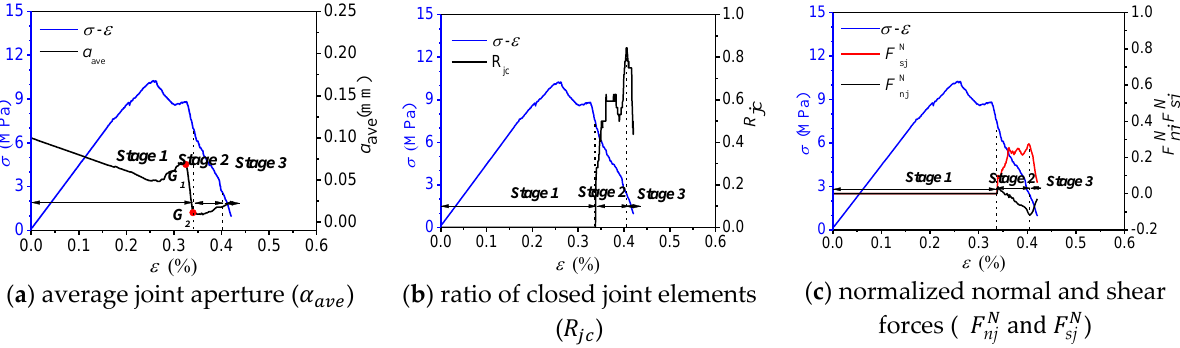
Energies 2021 , 14 , x FOR PEER REVIEW Figure 13. Evolution of the parameters of the joint system with increasing axial strain ( β = 45 ◦ ) Figure 13. Evolution of the parameters of the joint system with increasing axial strain ( 𝛽 =45°) Figure 13. Evolution of the parameters of the joint system with increasing axial strain ( 𝛽 =45°)